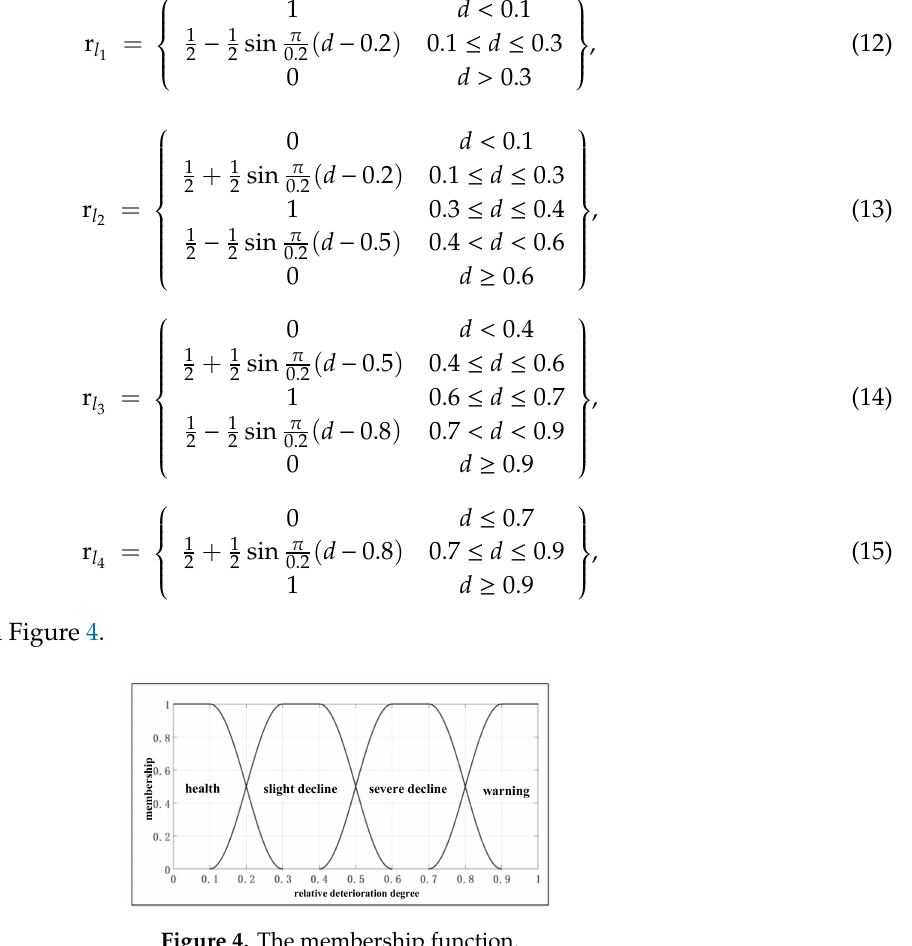
Figure 4. The membership